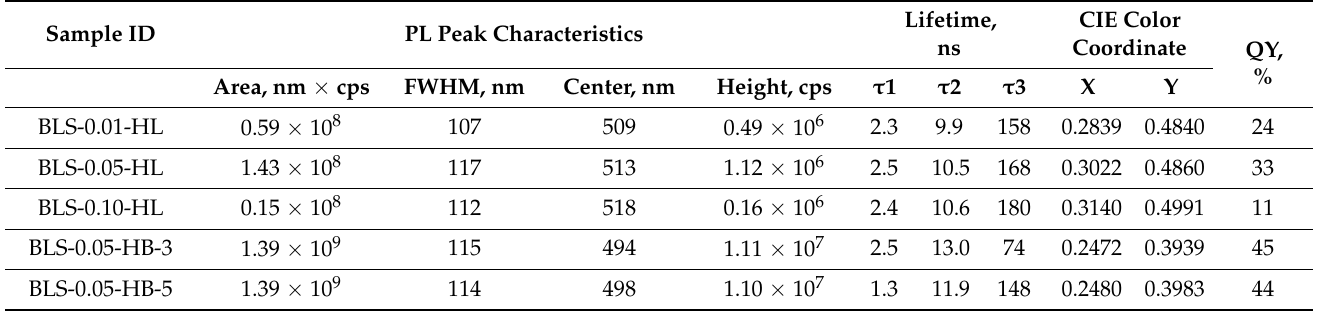
Figure 16. PL spectra of hydrophobic BoronLightSil samples with different concentrations of TMCS: (1) 3% for BLS-0.05-HB-3 sample and (2) 5% for BLS-0.05-HB-5 sample.